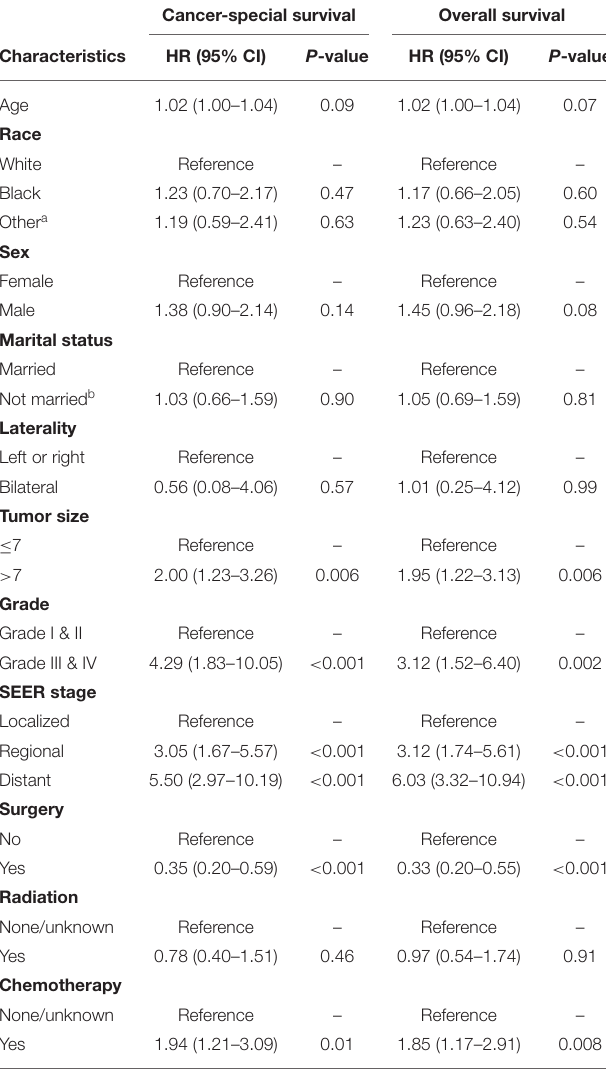
TABLE 3 | The multivariable Cox proportional hazard regression model of cancer-specific and overall survival for primary renal leiomyosarcoma. Cancer-special survival Overall